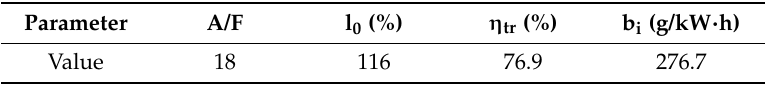
Table 6. OP2S-GDI engine performance with optimum scavenging system